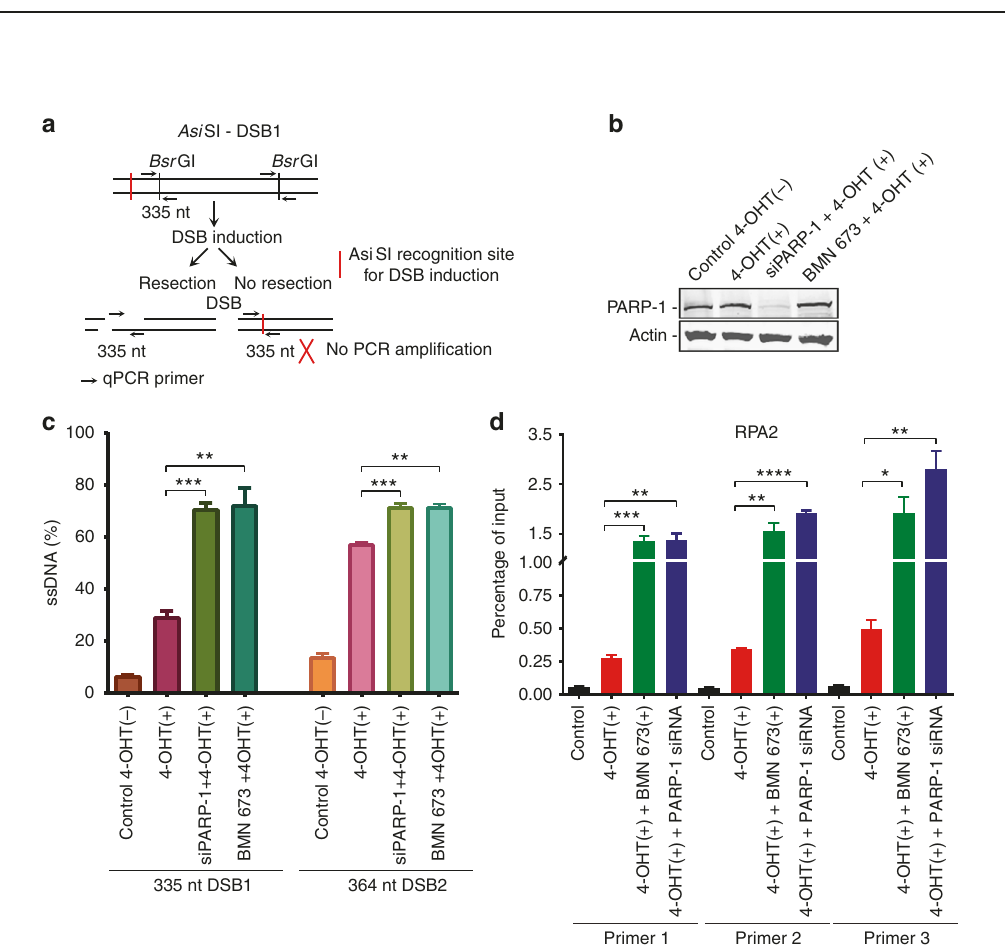
Fig. 1 Poly(ADP-ribose) polymerase-1 (PARP-1) regulates DNA end resection and chromatin accumulation of replication protein A (RPA). U2OS cells mock treated, treated with BMN 673, irradiated (10 Gy), or irradiated (10 Gy) in combination with BMN 673 were subjected to immuno fl uorescence against γ -H2AX, bromodeoxyuridine (BrdU) ( a ), or RPA2 foci formation ( b ). HeLa SilenciX cells underexpressing PARP-1 by siRNA-mediated gene knockdown were subjected to immuno fl uorescence against γ -H2AX, BrdU ( c ) or RPA2 foci formation after irradiation (10 Gy, 3 h release) ( d ). In panels a – d , the data show the mean ± s.d. (Mann – Whitney U test). e HEK293T wild type or CRISPR-PARP-1 were treated with 2 mM hydroxyurea for 16 h, fractionated into chromatin enriched, nuclear soluble and cytoplasmic fractions. f GFP-RPA1 recruitment in the absence (blue line) or presence of BMN 673 (orange line). The peak of intensity was at 6 s. Data show the mean ± s.e.m. g knockdown of CtIP suppresses the accumulation of single-stranded DNA in HeLa SilenciX PARP-1 knockdown cells after irradiation (10 Gy, 3 h release). The data show the mean ± s.d. **** p ≤ 0.0001 (Mann – Whitney U test). Source data are provided as a source data fi le